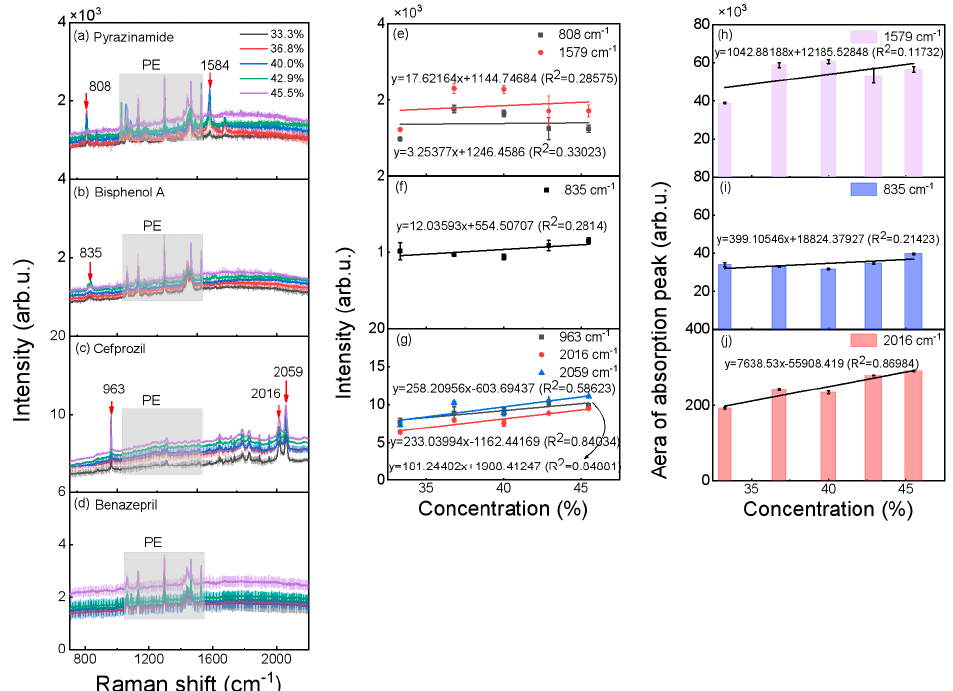
Figure 5. Raman spectra of ( a ) pyrazinamide, ( b ) bisphenol A, ( c ) cefprozil, and ( d ) benazepril under five different concentrations. The intensity of peaks for different concentrations of ( e ) pyrazinamide, ( f ) bisphenol A, and ( g ) cefprozil. The area under the peaks of ( h ) pyrazinamide, ( i ) bisphenol A, and ( j ) cefprozil. The corresponding error bar has been labelled.